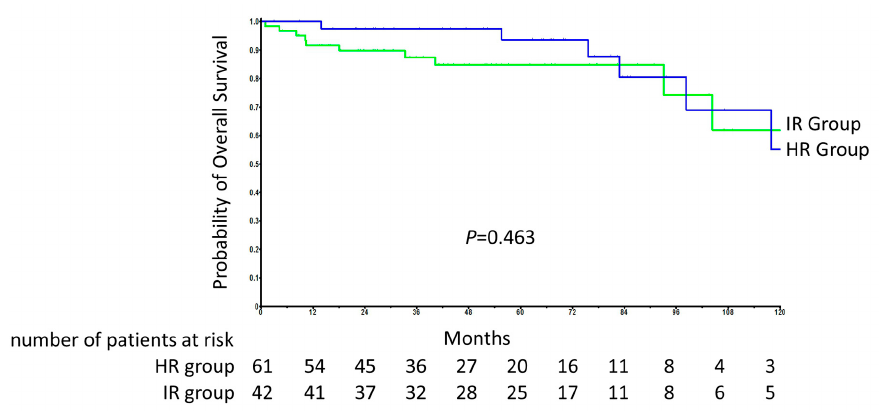
Figure 1. Overall survival (OS) and numbers at risk in groups A and B.